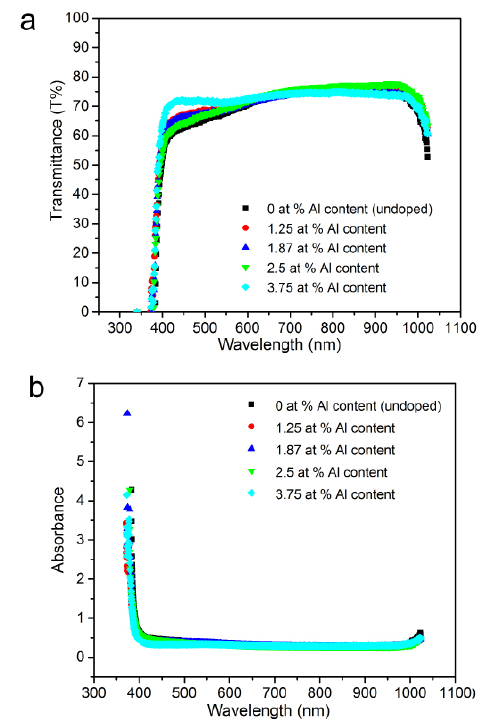
Fig. 4. (a) Transmission spectra of both undoped and Al-doped ZnO thin films, (b) Absorption spectra of both undoped and Al-doped ZnO thin films.